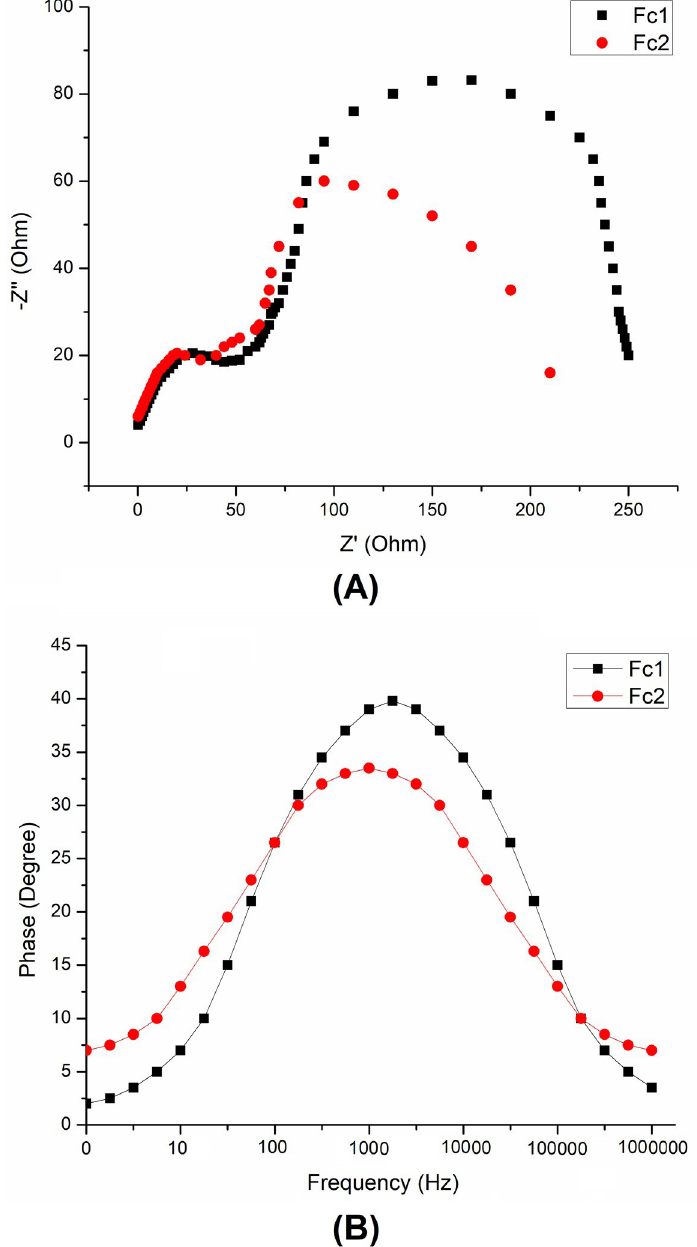
Fig 13. Electrochemical impedance spectra of (A) Nyquist plots (B) Bode-phase plots in DSSCs measured with a 10 mV AC signal under dark conditions. employment of good acceptor group (-F and -OCH ) as substituent atom in Fc2 , low lying the 3 HOMO-LUMO level ( E = 3.52 eV), afford a large dipole moment molecule ( μ = 2.35) and fur- g ther extended the visible region for the electronic absorption spectrum ( E = 2.54 eV) which g propose this ferrocenyl chalcone as an attractive organometallic compound for enhancing the cell efficiency in DSSCs ( η = 0.246%).